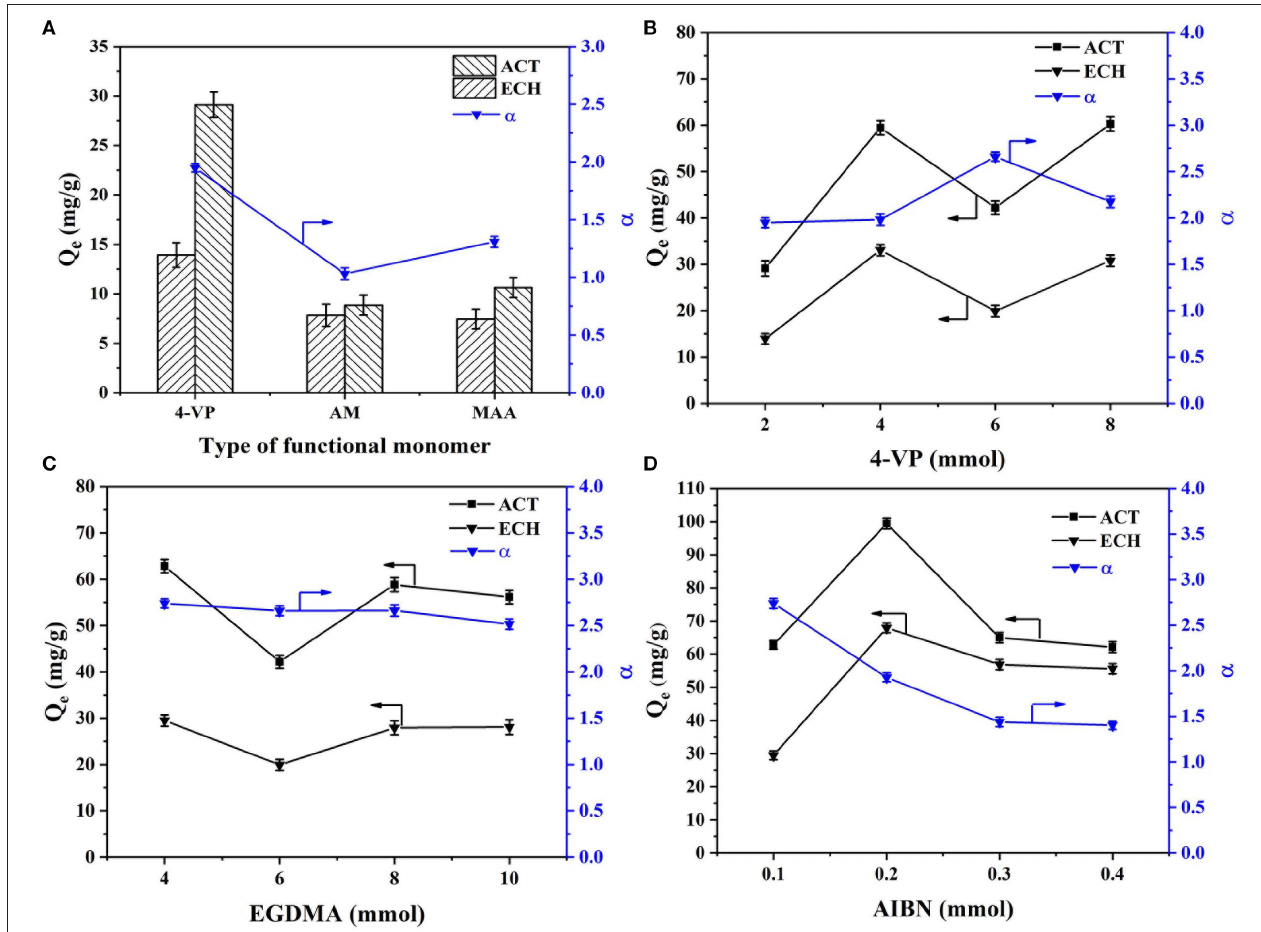
FIGURE 1 | Effects of the (A) type of functional monomer, (B) amount of functional monomer, (C) amount of crosslinking agent, and (D) amount of initiator on rebinding the capacity of MIMs at 30 ◦